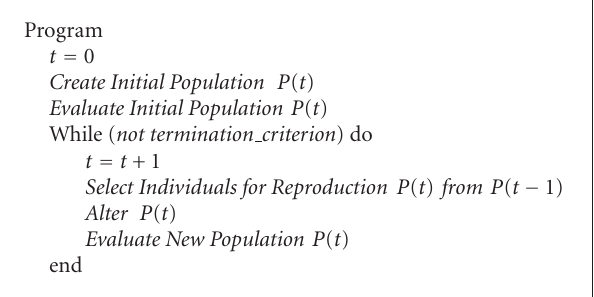
Algorithm 1: Evolution-based